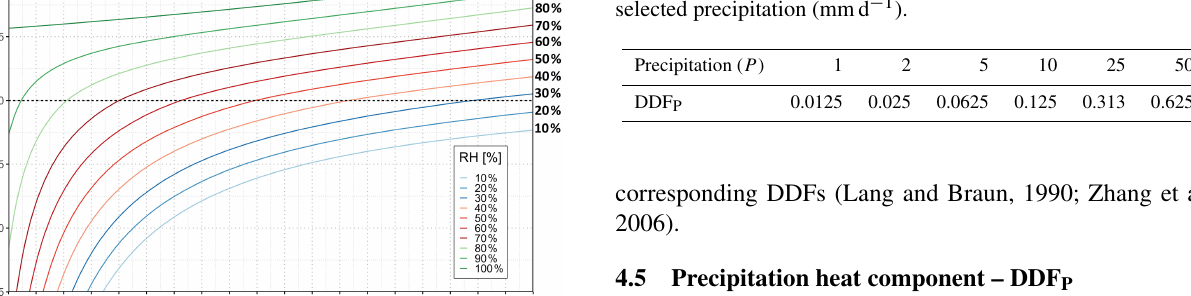
Table 2. Precipitation heat component (DDF P ) (mm ◦ C − 1 d − 1 ) for selected precipitation (mmd − 1